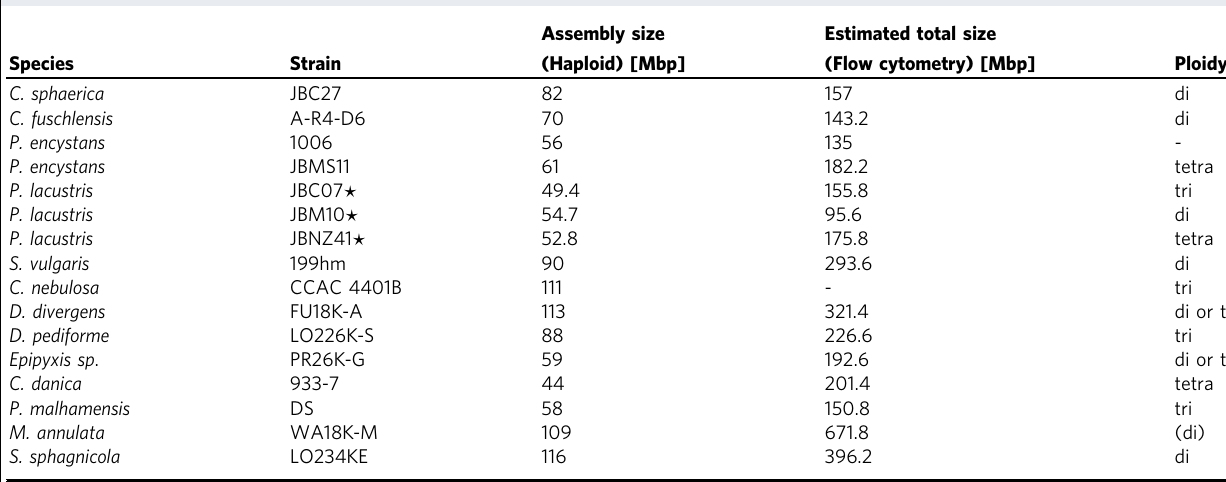
Table 2 Genome size estimations.